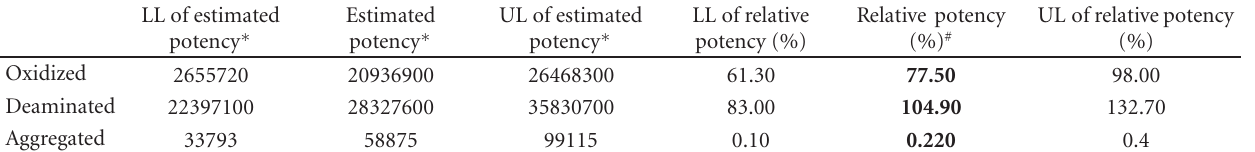
Figure 5: Test of the stability of the cell lines. Cells at three di ff erent stages (passage #15, 46, 51) were tested in this validation, which involved 3 replicates for each dose and in 3 replicate plates. Sample 1 was the in-house reference standard (a), with sample #2 and #3 being final drug products from syringes (b,c). Each sample was run in triplicate and tested on 3 di ff erent plates. The graphs represent the linear range of the tested doses as determined by comparison to the international reference standard. Table 2: Relative potency determination of IFN variants compared with the reference standards. LL of